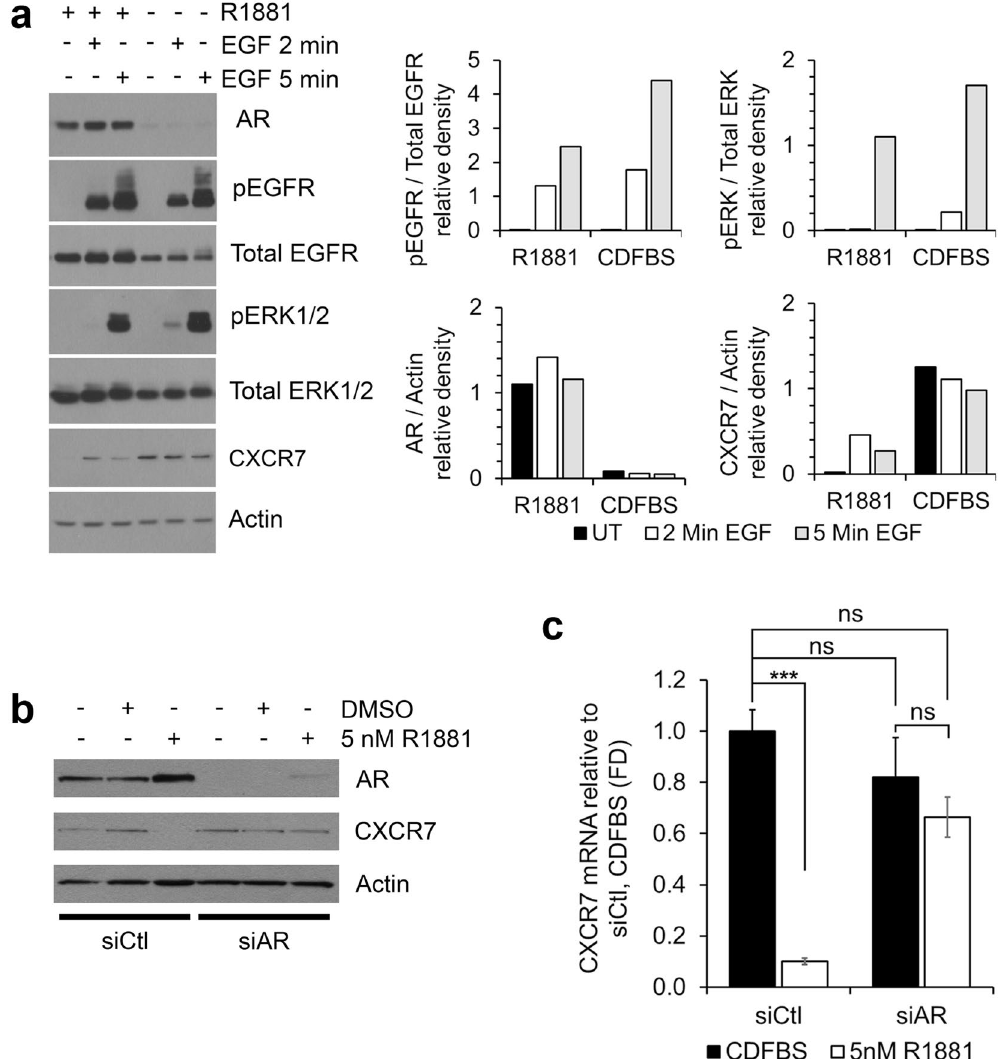
Figure 2. AR regulates CXCR7 expression and downstream EGFR-mediated mitogenic signaling. ( a ) Left: western blot panel of indicated proteins from LNCaP cells treated in the presence or absence of 5 nM R1881, followed by 2 or 5 minutes of EGF stimulation. Right: Densitometry analysis of phosphorylated protein relative to total; and AR or CXCR7 relative to actin. ( b ) Western blot panel of indicated proteins from LNCaP cells transfected with control siRNA (siCtl) or AR siRNA (siAR) treated with vehicle (DMSO) or 5 nM R1881. ( c ) CXCR7 mRNA expression in siCtl or siAR transfected cells with or without R1881 stimulation. n = 3, mean ± SEM; *** p < 0.001, ns = no significance; one-way ANOVA, secondary Tukey’s multiple comparisons test. The western blots shown in a and b are representative of three independent experiments with similar outcomes; densitometry is measured from the western blot panel CRISPR-Cas9 knockout of CXCR7 in C4-2B cells strongly reduces cell proliferation. We have shown that CXCR7 is directly repressed by AR, and that CXCR7 overexpression facilitates androgen-independent mitogenic signaling. Our next aim was to determine if CXCR7 is essential for this alternative signaling path- way to maintain androgen-independent cancer cell survival. Because previous work using stable short hairpin RNA (shRNA) expression was inefficient to maintain long-term CXCR7 depletion (data not shown), we uti- lized CRISPR-Cas9 to completely abrogate CXCR7 expression. Figure 4a shows the western blot confirmation of CXCR7 protein knockout in one C4-2B clone (CX7-KO) relative to control, non-specific CRISPR gRNA trans- fected C4-2B cells (Ctl). To investigate whether CX7-KO cells show differential sensitivity to the EGF stimulated mitogenic response, Ctl and CX7-KO cells were stimulated for 2 or 10 minutes with EGF after 24 h culture in low serum medium. Shown in Fig. 4b (repetition shown in Supplementary Fig. S2), in the CX7-KO cell line, pEGFR relative to total EGFR was reduced when compared to Ctl cells after 2 minutes of EGF stimulation (rela- tive density = 1.32 [Ctl] vs. 0.35 [CX7-KO]). After 10 minutes of EGF stimulation, the pEGFR/total EGFR ratio in Ctl cells declined but remained greater than in CX7-KO cells (relative density = 0.73 [Ctl] vs. 0.66 [CX7-KO]). Downstream pERK1/2 relative to total ERK1/2 was also reduced in CX7-KO compared to Ctl cells at 2 minutes